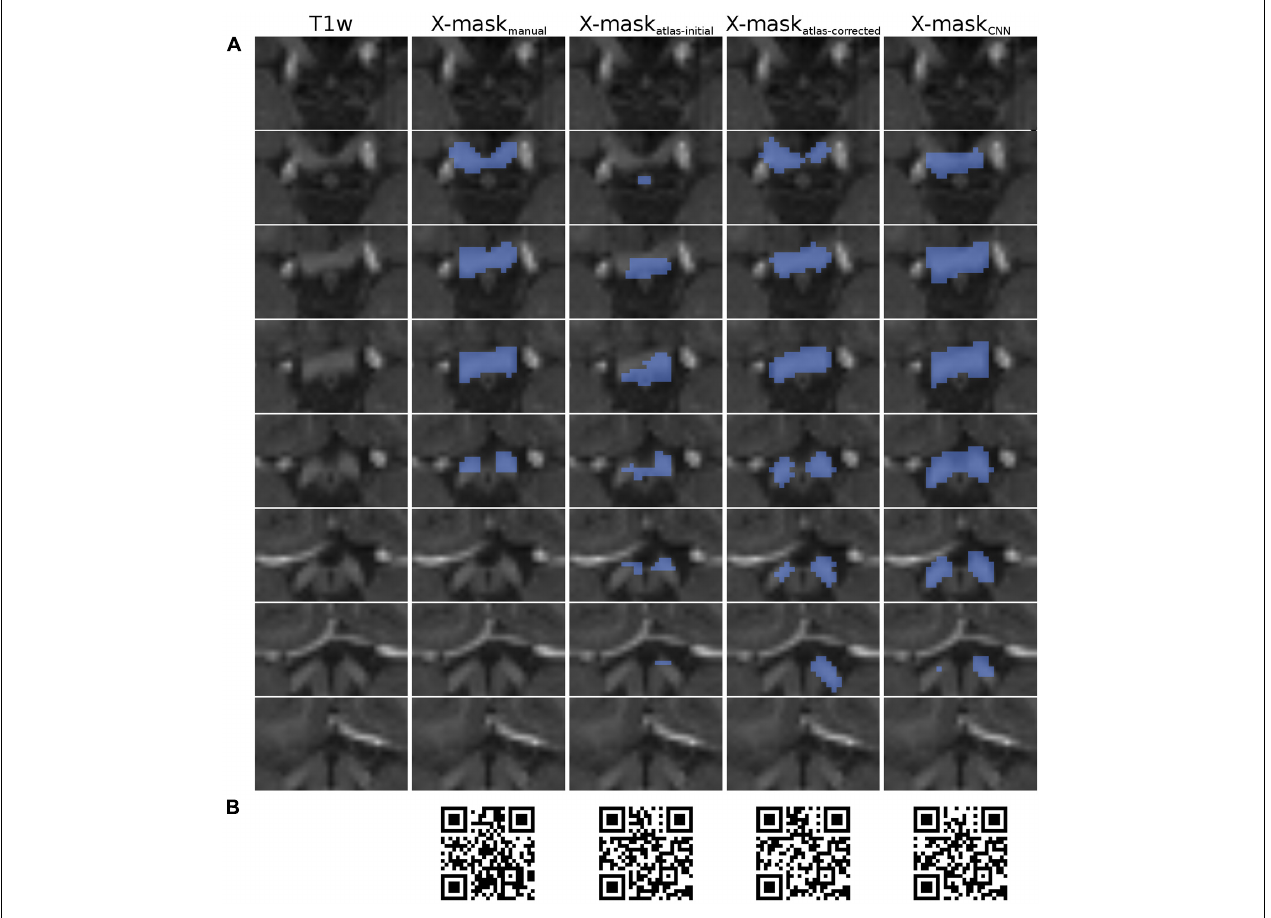
FIGURE 2 | Overview of X-mask from the exemplary HCP dataset (ID 304727). (A) Axial slices displaying the optic chiasm region on T1w image (leftmost column). Blue-colored masks superimposed on the T1w slices correspond to, respectively, from left to right: X-mask manual , X-mask atlas − initial , X-mask atlas − corrected , and X-mask CNN . The top row displays the most inferior slice, with subsequent rows showing incrementally superior slices. All images are presented in neurological convention. (B) QR codes allowing for the inspection of 3D representations of the masks, respectively, from left to right: X-mask manual , X-mask atlas − initial , X-mask atlas − corrected , and X-mask CNN